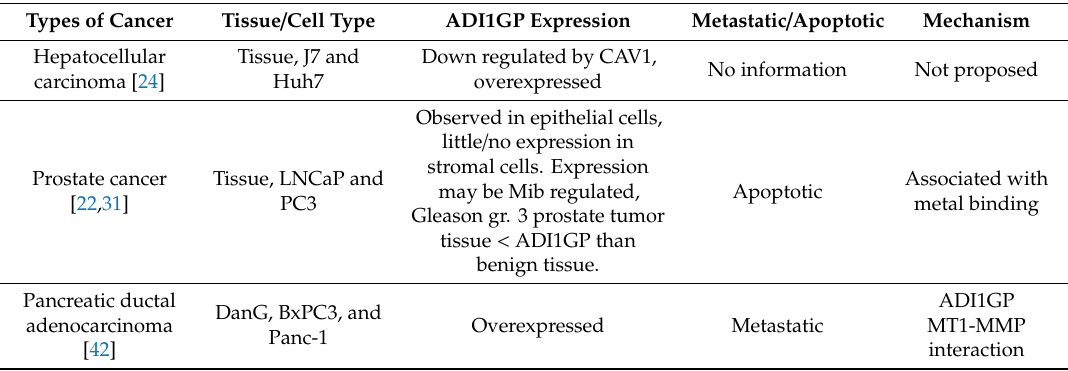
Table 2. ADI1 and ADI1GP dependences of cancer cell lines and